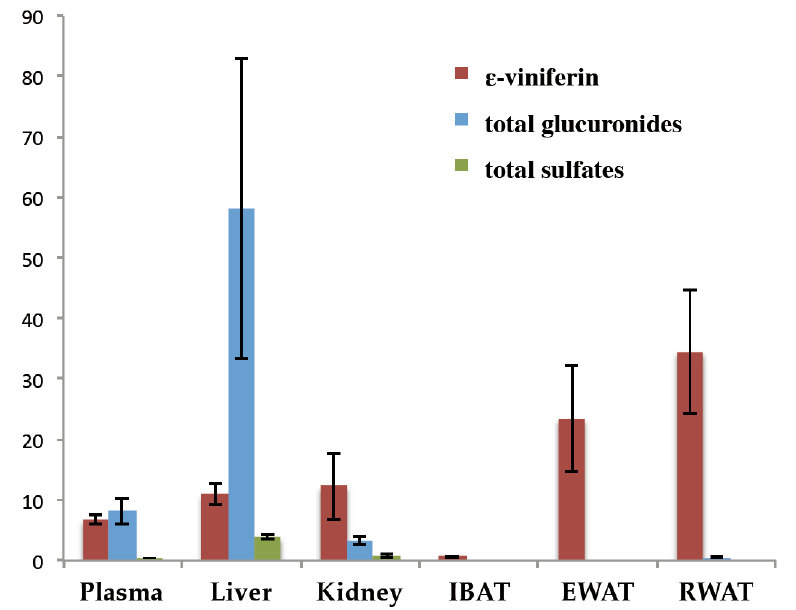
Figure 4. Concentrations ε -viniferin and its total glucuronide and total sulphate metabolites in plasma and organs 1 h after IP administration ( n = 6). Concentrations were expressed in nmol/mL for plasma and nmol/g for the